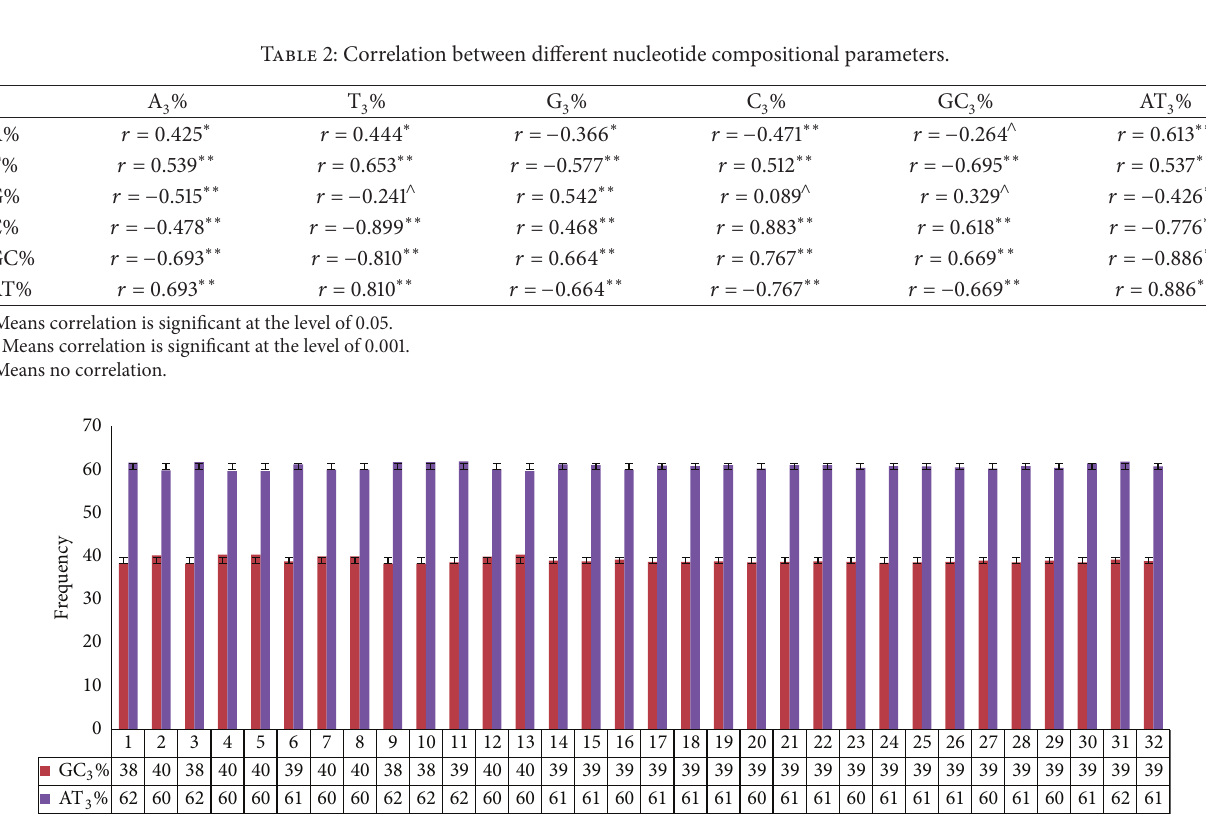
Figure 1: Comparison of AT and GC content at synonymous third codon positions in the genes under study. Clearly, AT 3 is much higher than GC 3 in all the